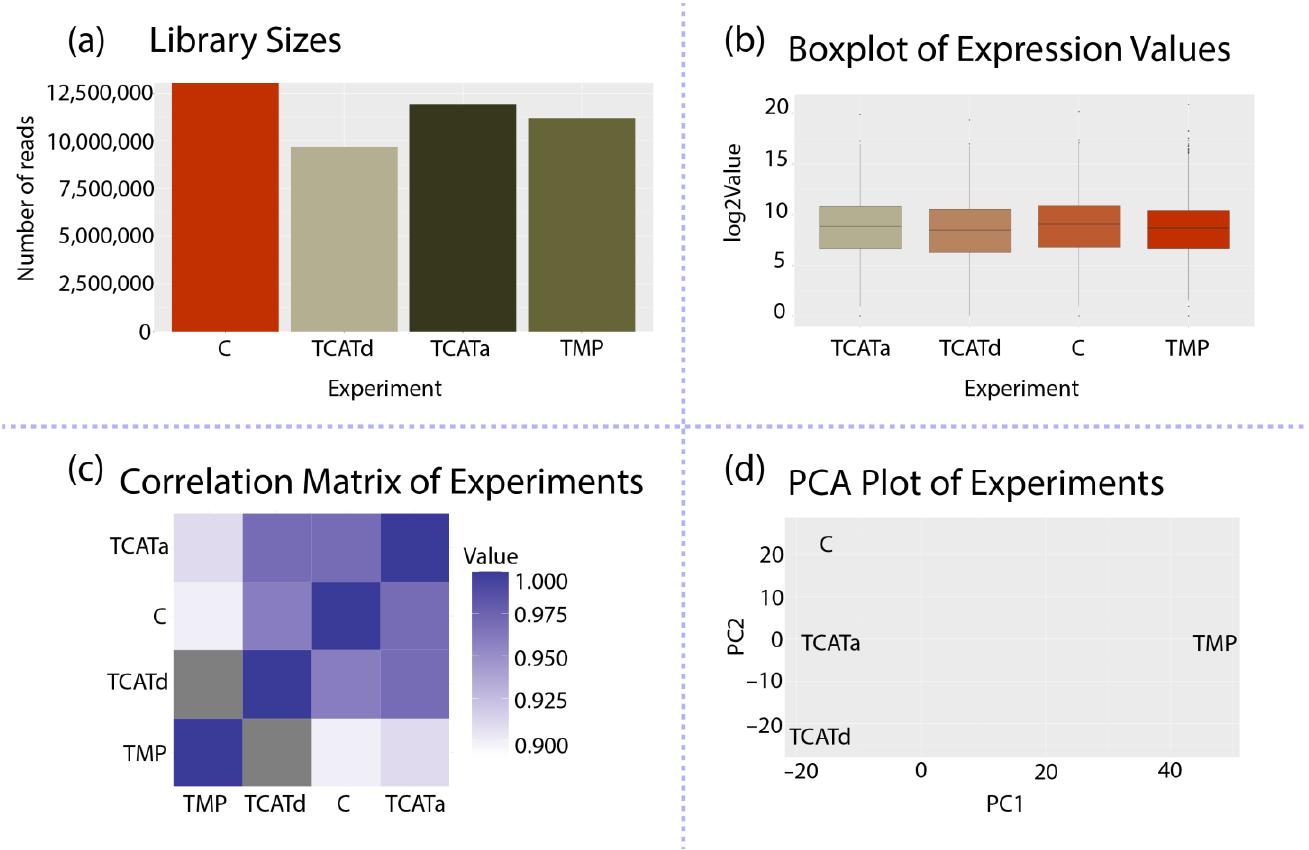
Figure 3. Results of global analysis of the dataset with T-REx: ( a ) library sizes; ( b ) box plot of normalized signals for each sample; ( c ) correlation matrix of the experiments; and ( d ) Principal Component Analysis (PCA) of the experiments. Experiment names are plotted as vectors (points).